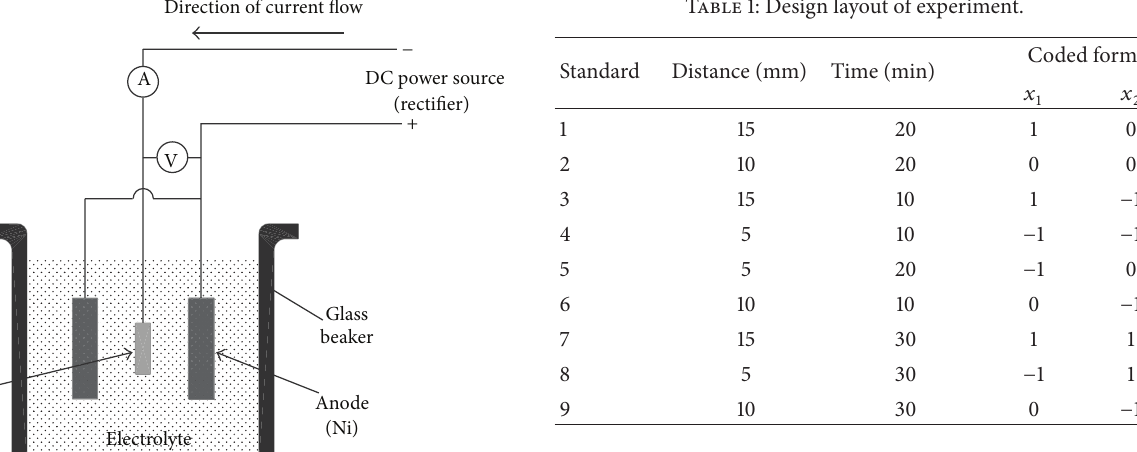
Table 1: Design layout of